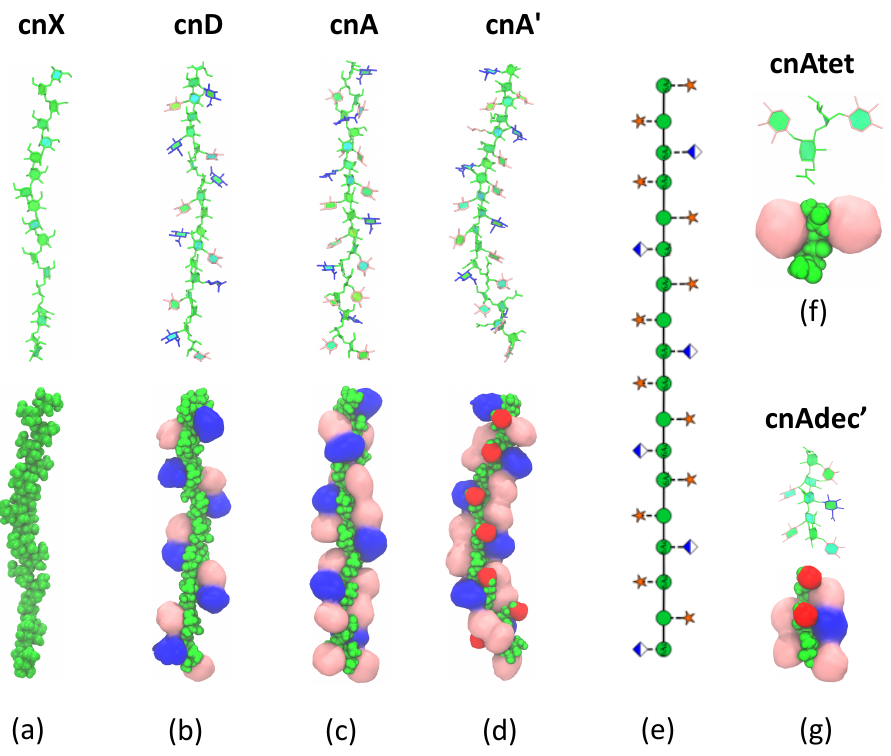
Figure 5. Dominant conformations of the GXM molecules shown with two representations in the VDM package [26]—the PaperChain visualisation [27] to highlight the conformation of the backbone and space-filling representations to highlight the exposed binding surface. Representative conformations are shown for ( a ) the unsubstituted mannan backbone cnX; ( b ) cnD; ( c ) cnA; ( d ) and cnA’ (6- O -acetylated). A schematic for the arrangement of the side chain substitutions is shown in ( e ) using the SNFG symbols for the sugar residues [13,14]. Representative conformations of the chain fragments are shown for the tetrasaccahride ( f ) cnAtet and the 6- O -acetylated decasaccharide ( g ) cnAdec’. The chain substitutions in all representations are coloured as follows: α DMan—green; β DGlcA—blue; β DXyl—pink and